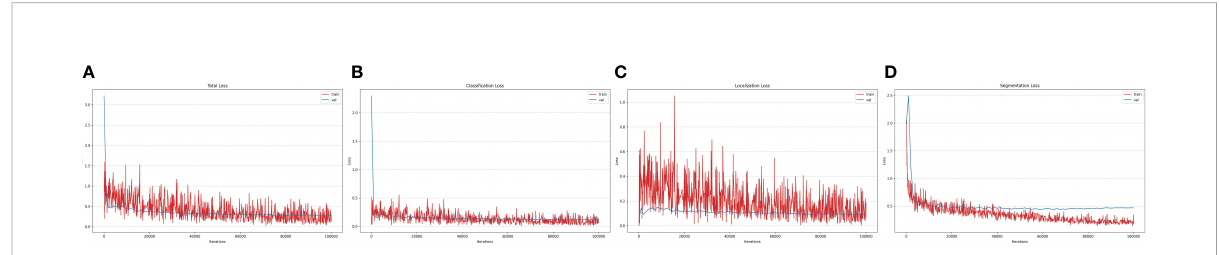
FIGURE 7 Loss curves of the DIANA framework. (A) Total loss, (B) classi fi cation loss, (C) localization loss, and (D) segmentation loss.